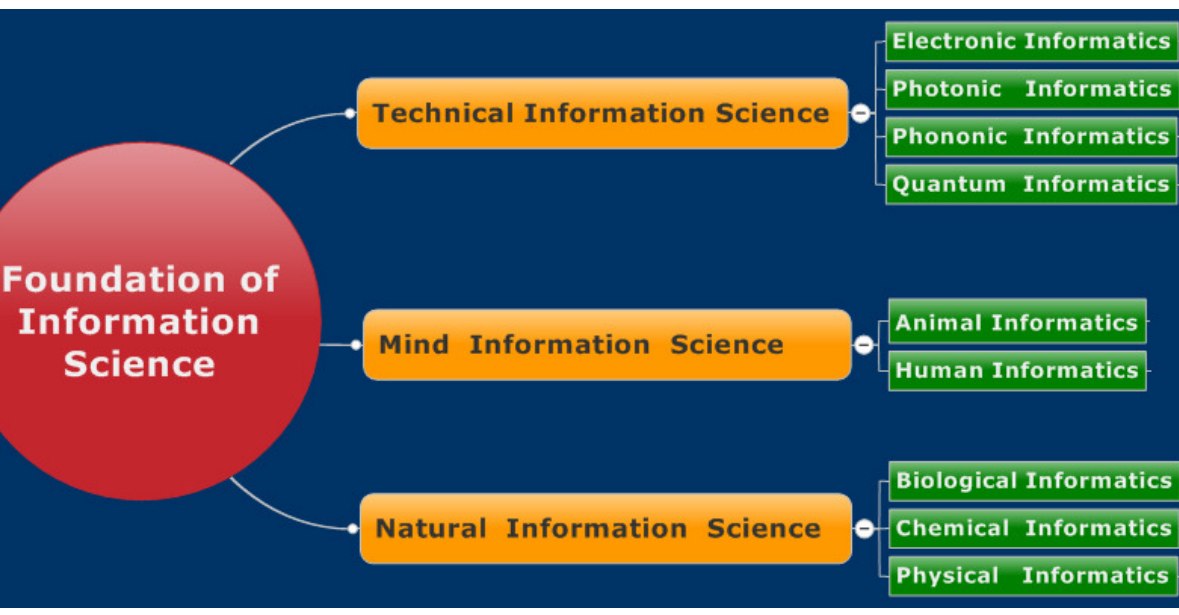
Figure 1. A simple diagram for contemporary information disciplines